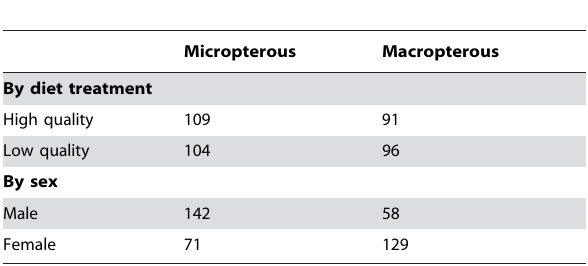
Table 1. The observed frequencies for the two types of wing morph partitioned by diet quality treatment and sex.